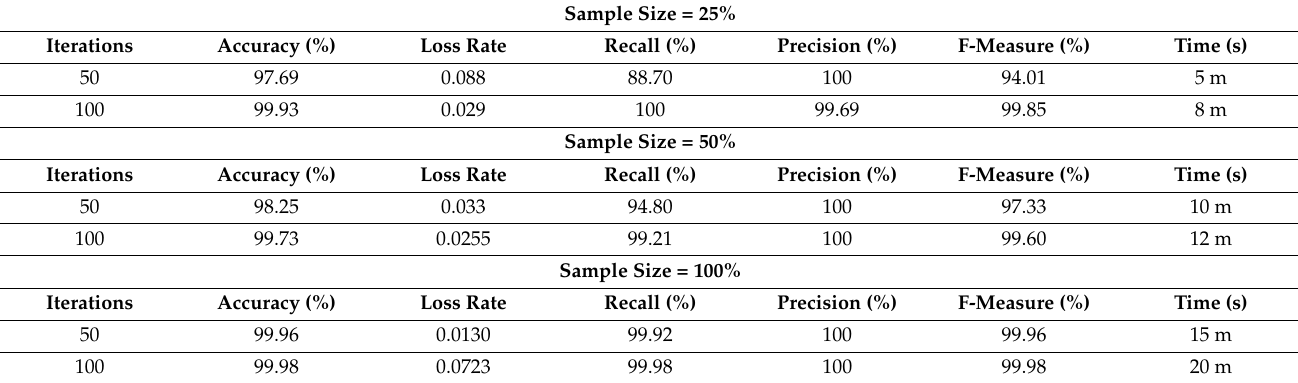
Table 7. Experimental results of the first